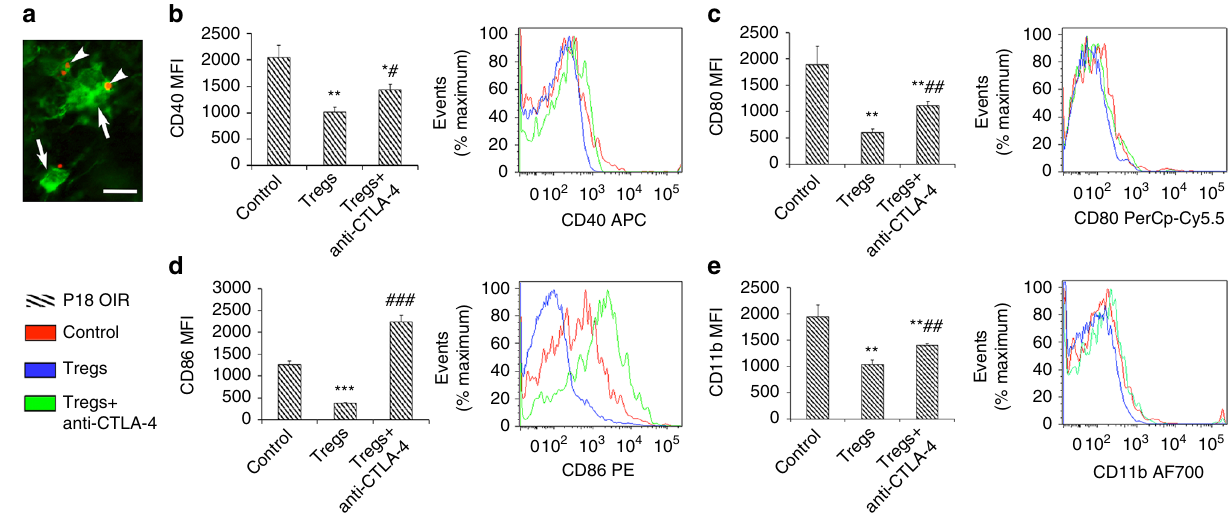
Fig. 8 The activation state of OIR microglia is altered by Tregs. a Representative confocal image of a fl at mounted retina from Foxp3 rfp mice at postnatal day (P) 18 with OIR and treated with the IL-2/anti-Il-2 mAb complex. Foxp3 + cells ( red , arrowheads ) contact microglia (Iba1 immunolabeling in green , arrows ). Scale bar , 40 μ m. b – e Microglia from retinas of OIR mice at P18 were co-cultured with Tregs puri fi ed from adult mouse spleen and incubated with a blocking anti-CTLA-4 mAb (10 μ g/ml). Flow cytometry was performed and mean fl uorescence intensity (MFI) quantitated for b CD40, c CD80, d CD86, and e CD11b. Fluorochromes are allophycocyanin ( APC ), PerCp-Cy5.5, phycoerythrin ( PE ), and AF700. * P < 0.05, ** P < 0.01, and ** P < 0.001 to OIR control. # P < 0.05, ## P < 0.01, and ### P < 0.001 to OIR + Tregs. Data are representative of two independent experiments each containing three replicates (one-way ANOVA with Student ’ s t test). Values are expressed as mean ± Flow cytometry . The retina, spleen, and lymph nodes (pooled inguinal, auxillary, brachial, deep cervical, and super fi cial cervical) were excised in Hank ’ s Balanced